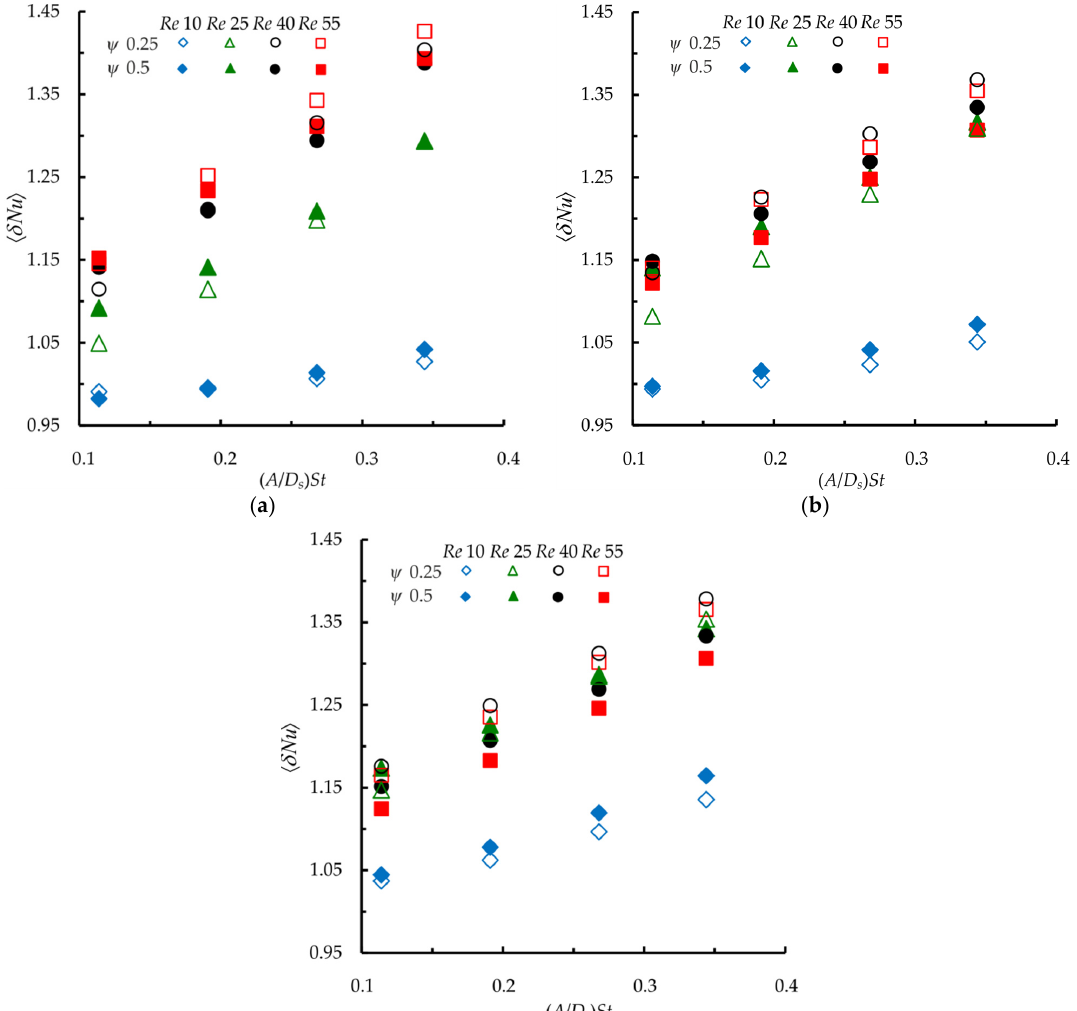
Figure 13. The effect of the pulsating flow on the Nusselt number ratio averaged over one period of pulsation for different porosities: ( a ) ε = 0.743, ( b ) ε = 0.864. ( c ) ε = 0.954.